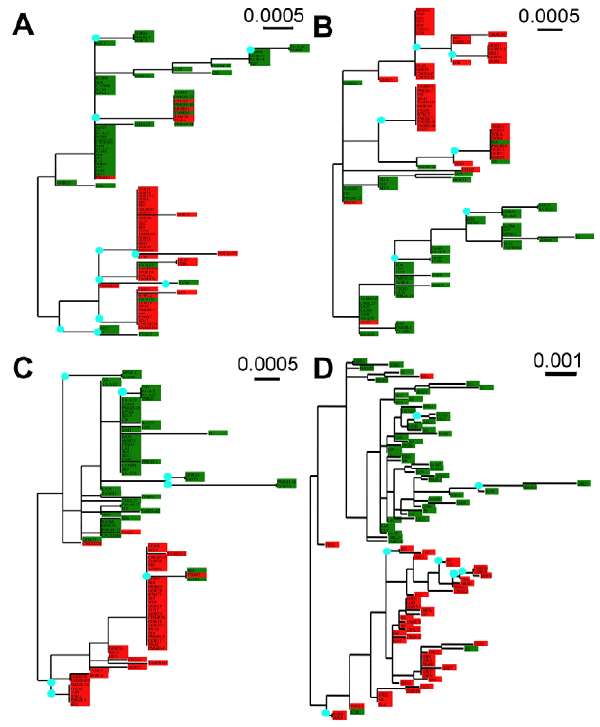
Figure 4. Phylogenies of single-copy genes. Phylogenetic trees were inferred from the DNA sequences for each of the three single copy genes (A) CRN (N=94), (B) PMS1 (N=94), and (C) Mlh1a (N=94), and from the concatenation of all the three genes (N=94; D). Blue dots indicate nodes where bootstrap support is $ 50. The clustering of type 1 (green) and type 2 (red) isolates supports the two-type population structure. Instances of unlike clustering resulting in non-homologous tree topology provide possible evidence for cases of recombination.